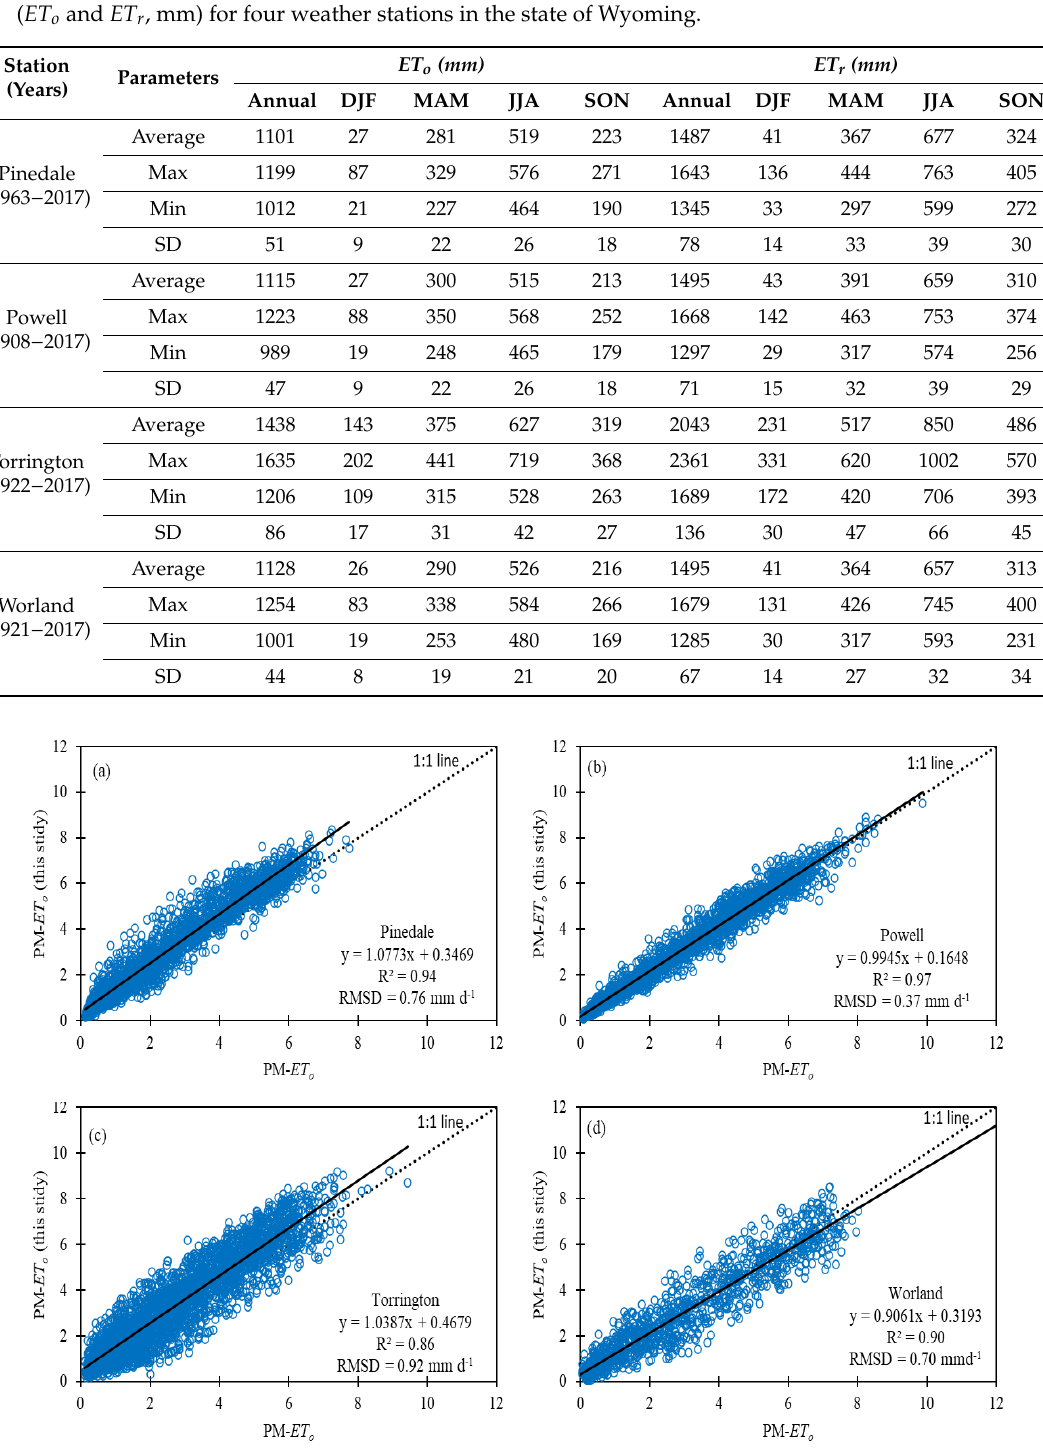
Figure 6. Comparison of reference evapotranspiration ( ET o , mm d − 1 ) estimated using modeled variables Penman − Monteith (PM)– ET o (this study) against the Standardized Penman − Monteith estimated reference evapotranspiration (FAO-56) estimated using full measured climate dataset at ( a ) Pinedale (2011 to 2017), ( b ) Powell (2010 to 2017), ( c ) Torrington (2008 to 2017) and ( d ) Worland (2014−2017). Table 6. Descriptive statistics for annual and seasonal grass and alfalfa reference evapotranspiration ( ET o and ET r , mm) for four weather stations in the state of Wyoming.